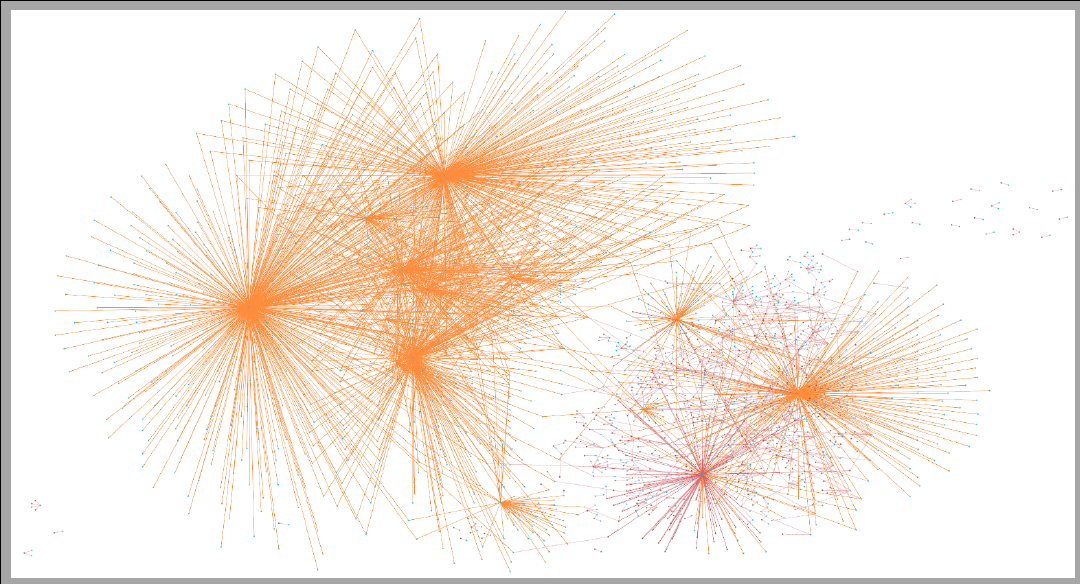
Figure 10. A subset of the graph produced by TigerGraph on the result of the query for the third kernel, Ranking Las Vegas by Friends’ Sentiment but on the user Kate from the first kernel. The topology of Kate’s friend groups suggest a very cliquey circle of friends with influence not far from her own.